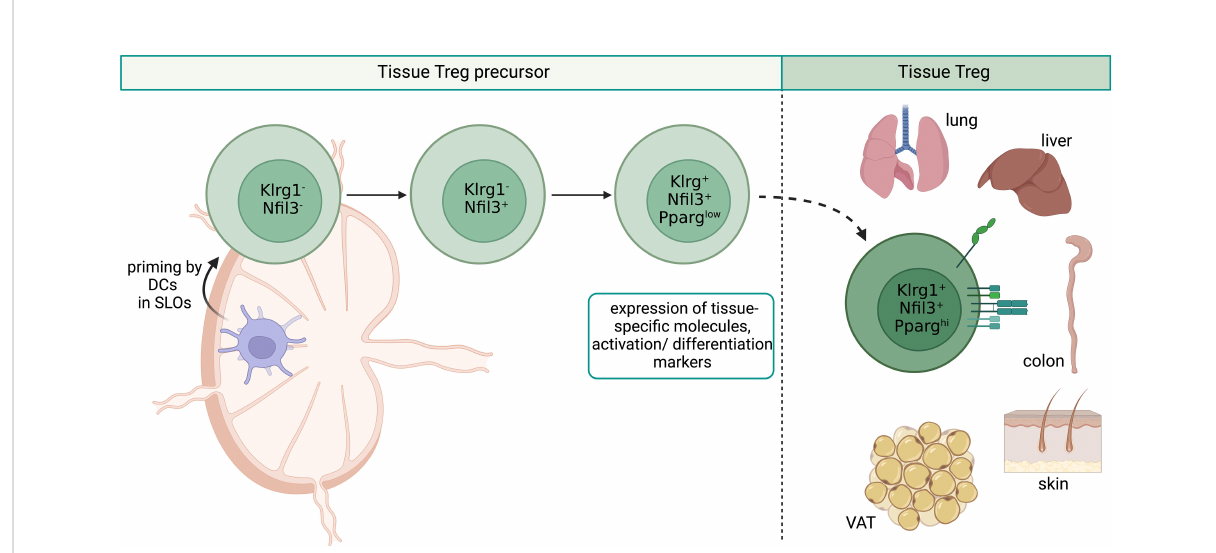
FIGURE 2 Overview of tissue Treg cell epigenetics in SLOs. Priming by DCs in SLOs leads to the stepwise development of tissue Treg cell precursors from Klrg1 - N fi l3 - over Klrg1 - N fi l3 + to Klrg1 + N fi l3 + . Klrg1 + N fi l3 + Treg cell precursors additionally express low levels of PPAR g , tissue-speci fi c genes like Itgb1 , Cxcr3 , Ccr9 , Itga4 , and activation/differentiation related genes such as Klrg1 , Pdcd1 and Rora . Klrg1 + N fi l3 + Treg cell precursors migrate to NLTs like VAT, skin, lungs, liver and colon. SLOs, secondary lymphoid organs; DCs, dendritic cells; Treg, regulatory T cell; NLTs, non-lymphoid tissues; VAT, visceral adipose tissue. Created with